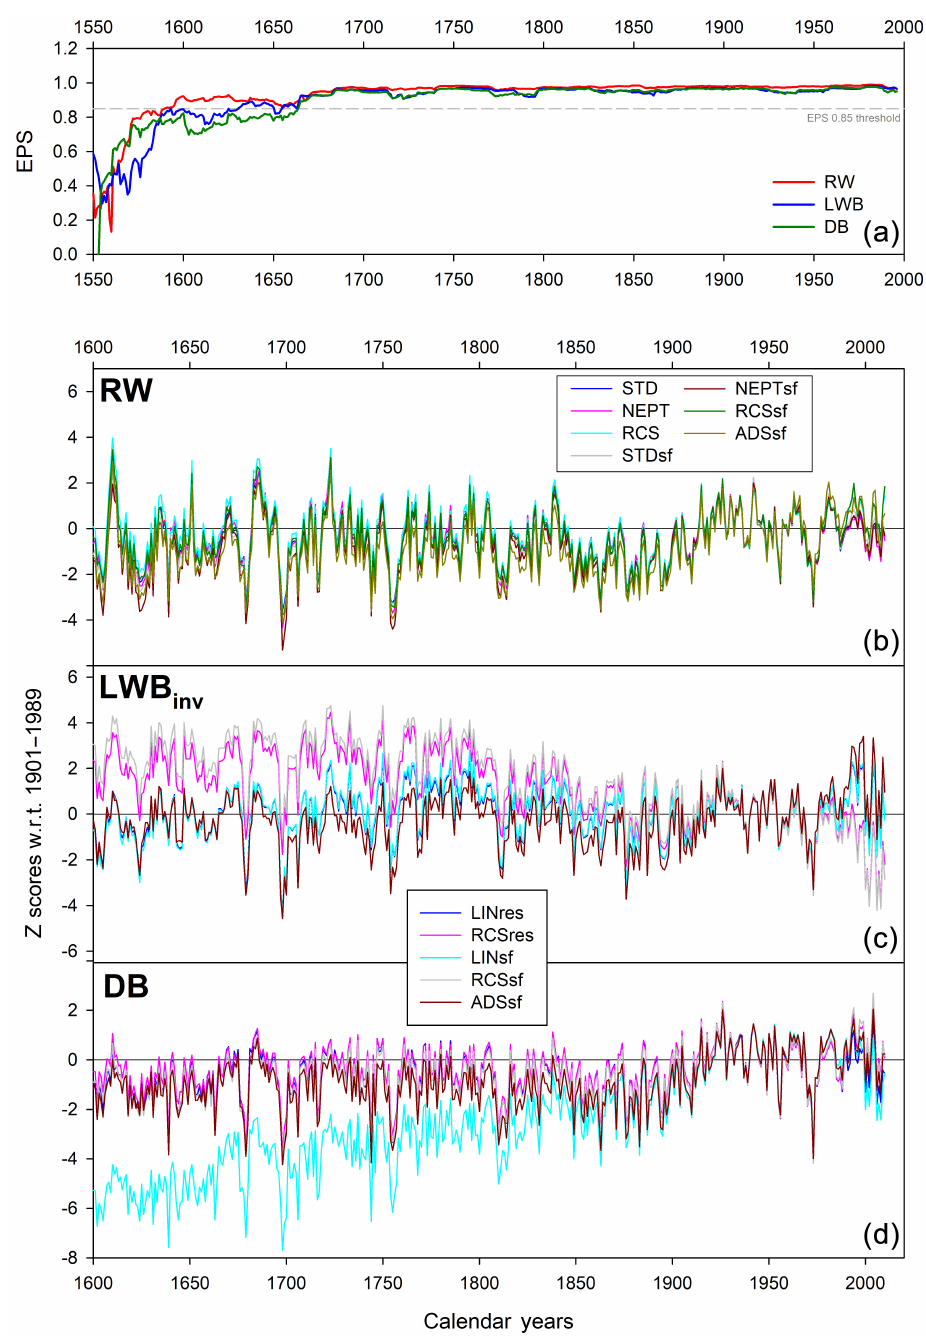
Figure 6. Detrending experiments for each TR variable using the full GOA regional composite (data from all eight sites). Panel (a) shows 31-year moving EPS plots for RW, LWB inv , and DB using 200-year spline detrending. Panels (b, c, d) present chronology variants from 1600 to 2010. RW – STD: negative exponential detrending (ratio) or regression function of zero or negative slope; NEPT: as STD but raw data have been power transformed and detrended via subtraction; RCS: single-group RCS detrending (ratio); STDsf, NEPTsf, and RCSsf: as previous three options but using signal-free detrending; ADSsf: age-dependent spline detrending using signal-free detrending. For LWB inv and DB – LINres: detrending via subtraction using linear functions (negative or zero slope); RCSres: as RCS above but detrending via subtraction; LINsf and RCSsf: as with LINres and RCSres but with signal-free detrending; ADSsf: age-dependent spline detrending using signal-free